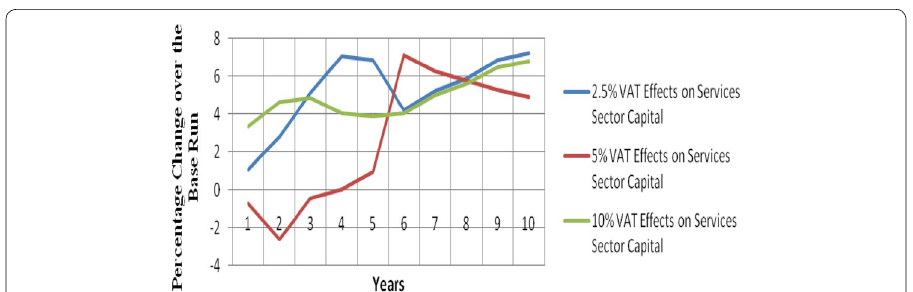
Fig. 33 Changes in capital stock in services sector